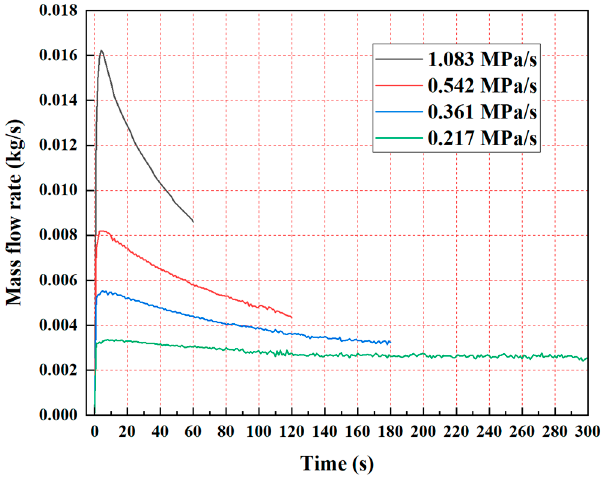
Figure 10. Hydrogen mass flow rates from different filling rates.